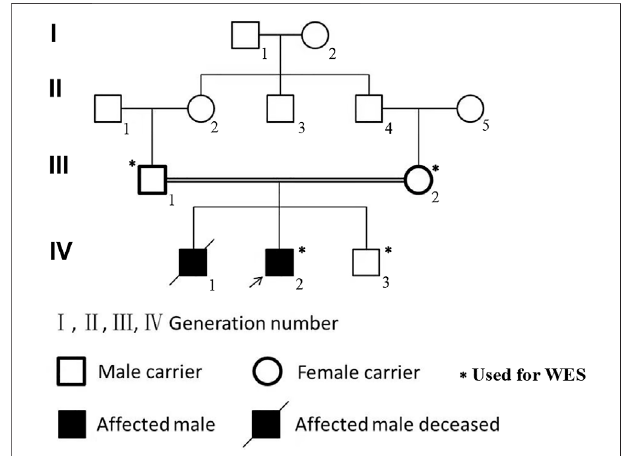
FIGURE 1 | The pedigree of the family with NPHP2/INVS mutation (c.1909C > T) in the exon 15. Affected brothers of INVS mutation are represented by black symbols. Males are represented by squares, and females are represented by round symbols. Crossed symbols represent deceased